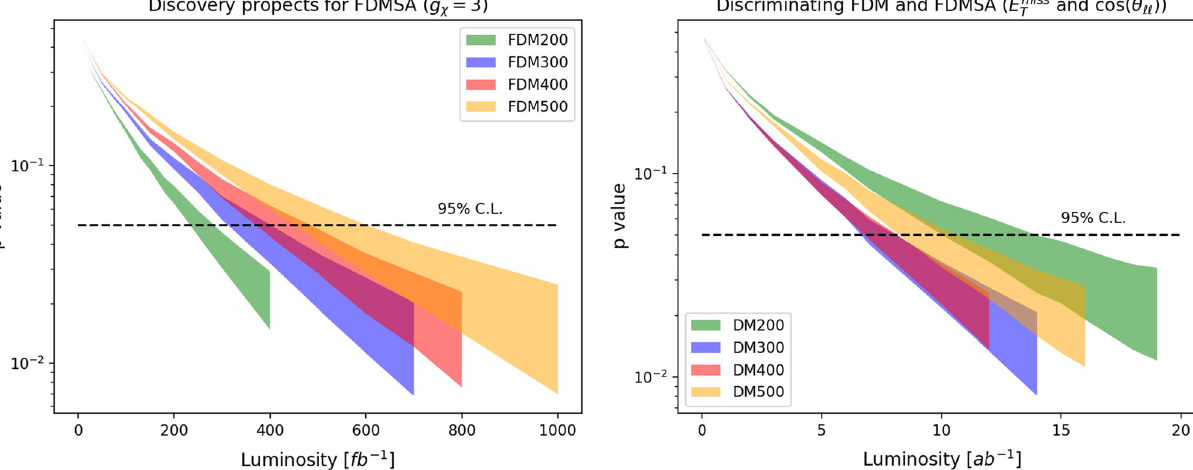
Fig. 13 Left: discovery prospects of benchmark points in FDMSA model; Right: discriminating prospects between FDM and FDMSA models. The systematic uncertainties are taken to be 1% and 0.5% in discovery and discrimination,